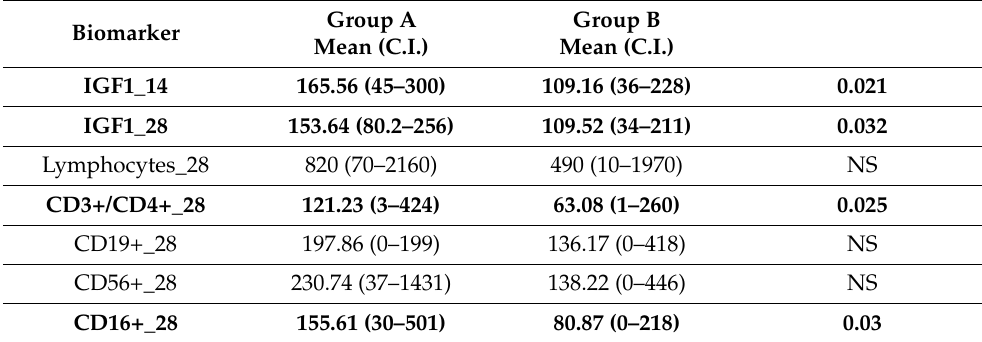
Table 4. Levels of IGF-1 14 and 18 days after alloHSCT (ng/mL) and total lymphocytes and B, T, and NK cells (mature CD16+ and immature CD56+) 28 days after alloHSCT (cells/microliter). Group A Biomarker Mean